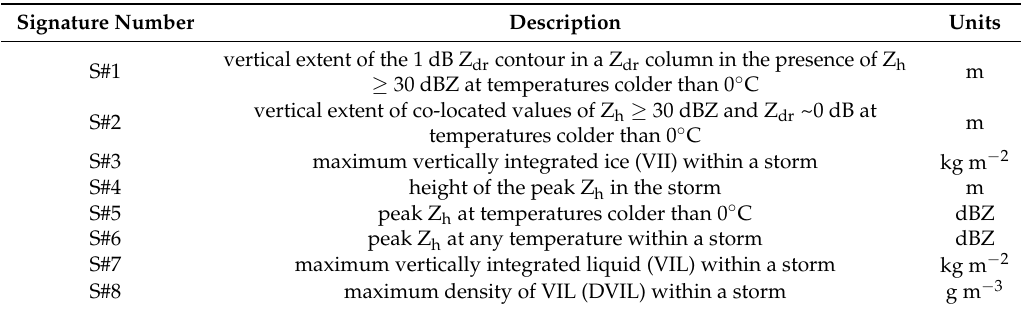
Table 1. Radar signature numbers, physical descriptions, and